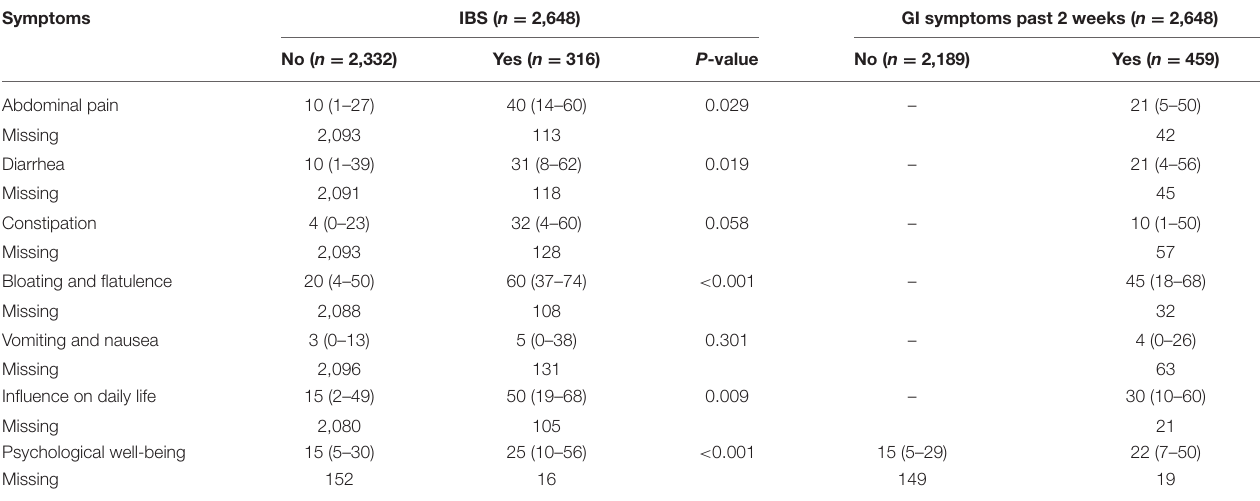
TABLE 1 | Distribution of gastrointestinal symptoms.